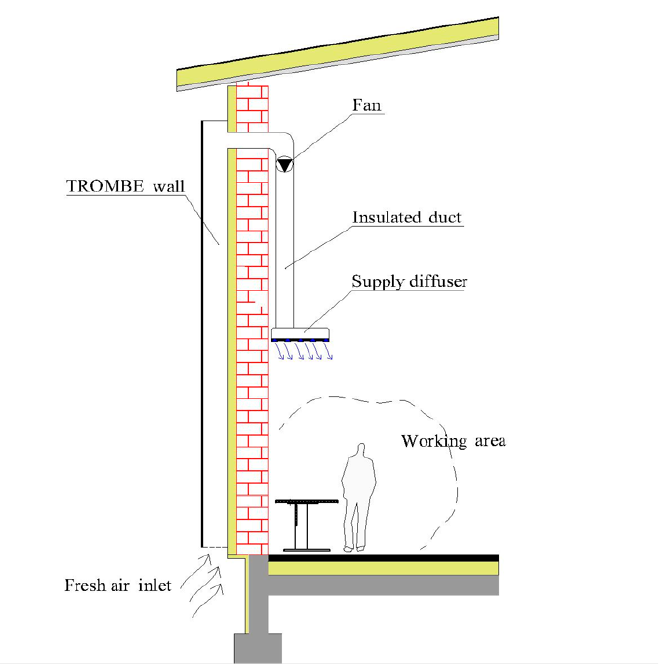
Figure 6. Optimal Trombe wall system layout and configuration for the examined case of a factory